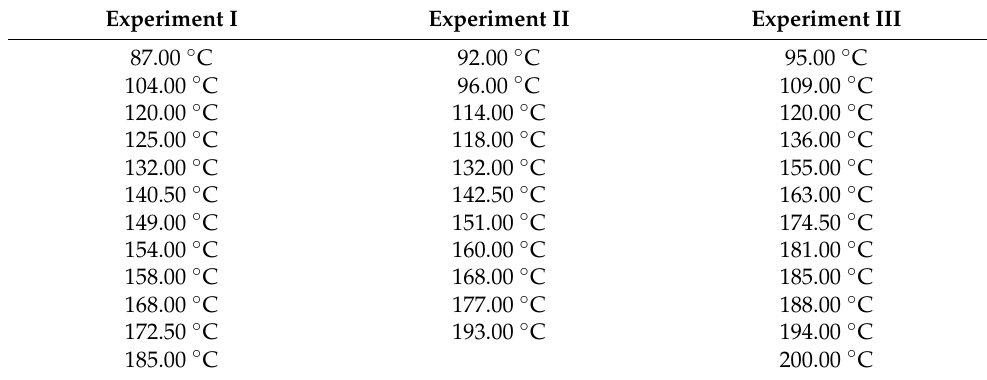
Table 2. The obtained surface temperature values for each experimental set.